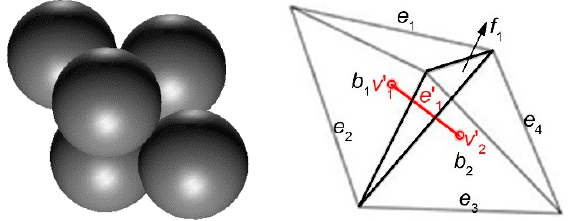
Figure 3. The pack of five particles ( left ) and its two dual geometrical systems ( right ). (v, e , f , b are the vertex, the edge, the face, and the body in the void cell system, respectively. v (cid:48) , e (cid:48) , f (cid:48) , b (cid:48) are the vertex, the edge, the face, and the body in the solid cell system, respectively.)